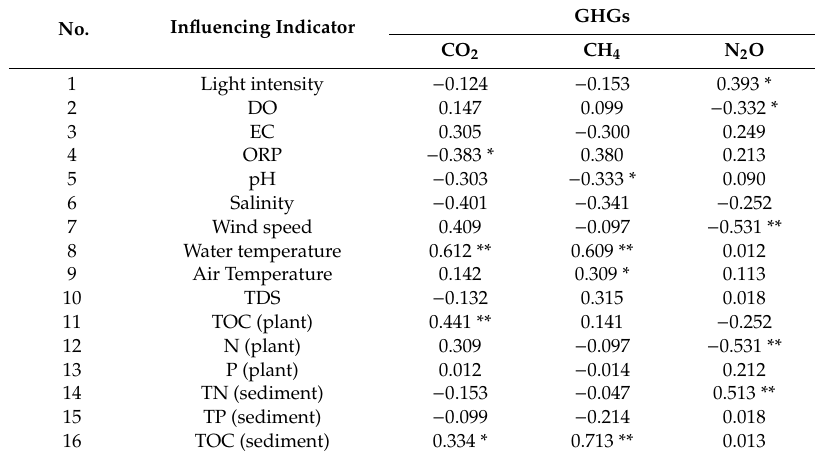
Table 3. Pearson’s correlation coe ffi cient between GHG fluxes and influencing